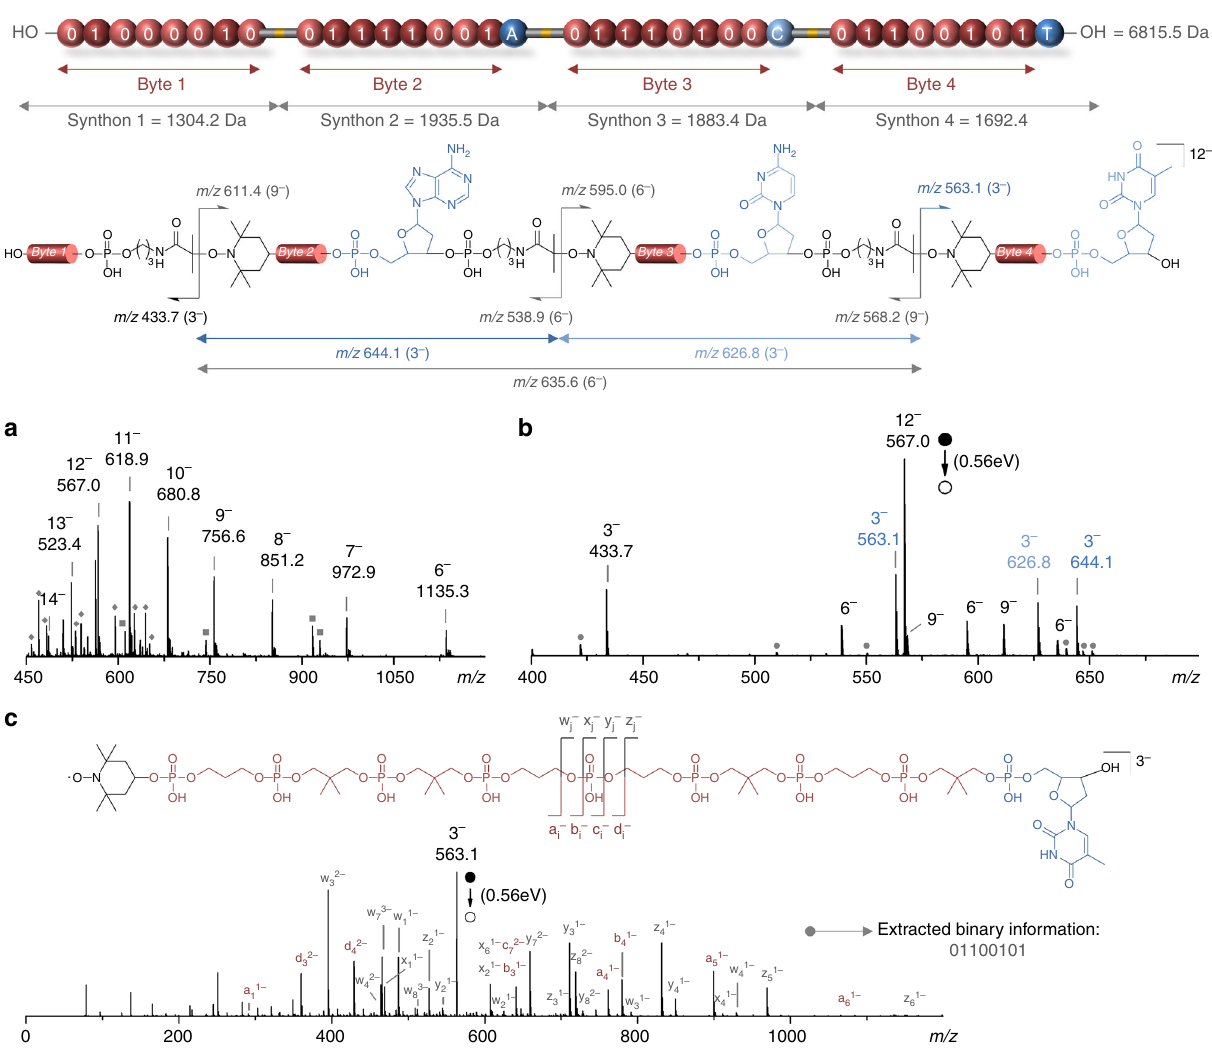
Fig. 2 Sequencing of a 4-byte digital polymer that contains the ASCII-encoded word Byte. a High-resolution electrospray mass spectrum (MS 1 ) obtained in the negative ion mode for a 4-byte digital polymer (Supplementary Table 1, Entry 5). The upper numbers represent the different charge states observed for the polymer. Dark grey diamonds indicate in-source fragments (see Supplementary Table 2 for a detailed interpretation of each peak) and dark grey squares designate different charge states of two different synthesis impurities. b MS 2 spectrum (0.56 eV, center of mass frame) obtained by collision- induced dissociation of the [M-12H] 12 − precursor ion, which carries on average three charges per byte. In this case, the MS/MS single-byte, double-byte, and triple-byte fragments are predominantly observed as trianions, hexa-anions, and nona-anions, respectively. Other charge states can be observed to a minor extent and are denoted by dark grey circles (see Supplementary Table 2 for a detailed interpretation of each peak). c Molecular sequencing (pseudo- MS 3 ) of a byte fragment obtained by collision-induced dissociation (0.56 eV, center of mass frame) of the precursor trianion [M-3H] 3 − . For clarity, only the sequencing of byte 4 is shown as an example in this fi gure. The sequencing of bytes 1 – 3 is shown in Supplementary Fig.